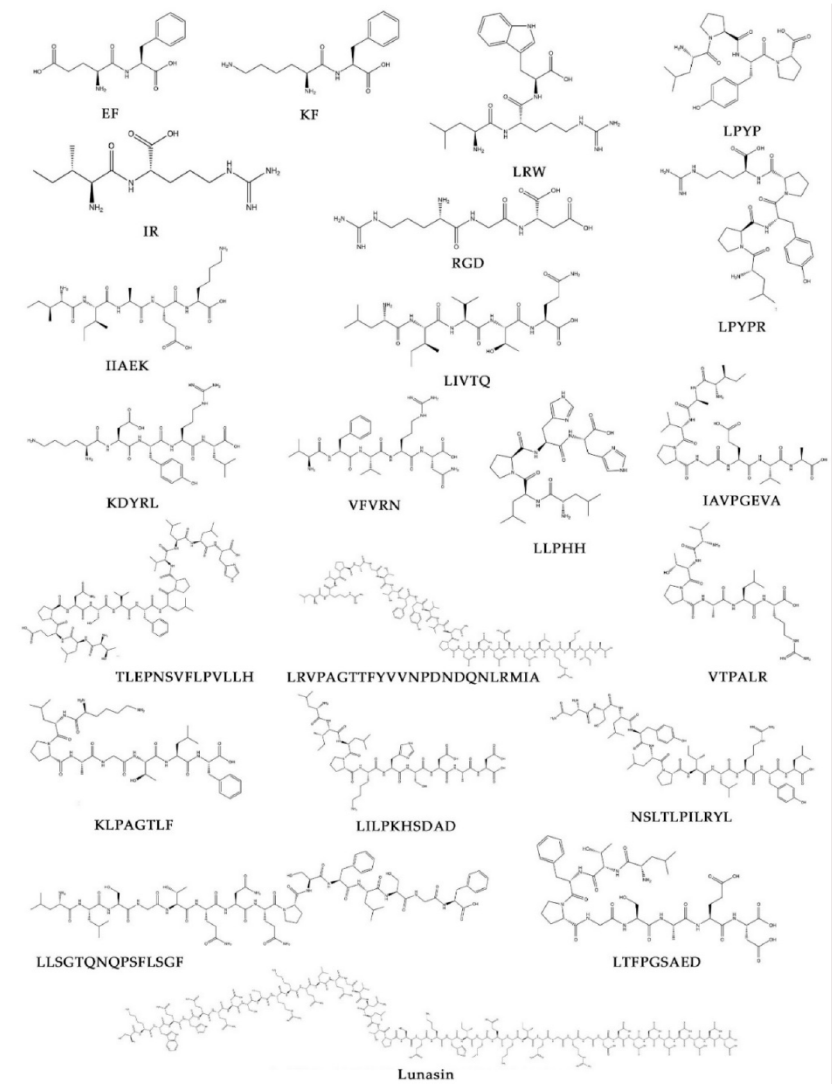
Figure 1. Chemical structures of the 22 peptides associated with cardiovascular health discussed in this manuscript. These chemical structures were developed using ChemDraw Ultra 12.0 (PerkinElmer, Cambridge, MA,